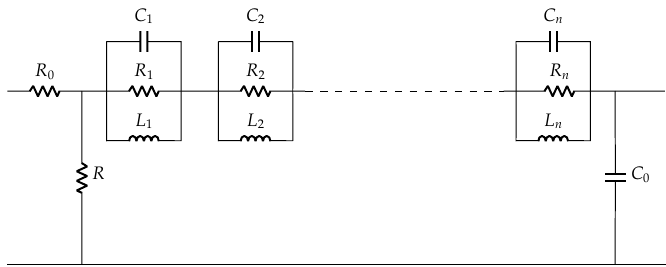
Figure 11. Equivalent circuit model of piezoelectric